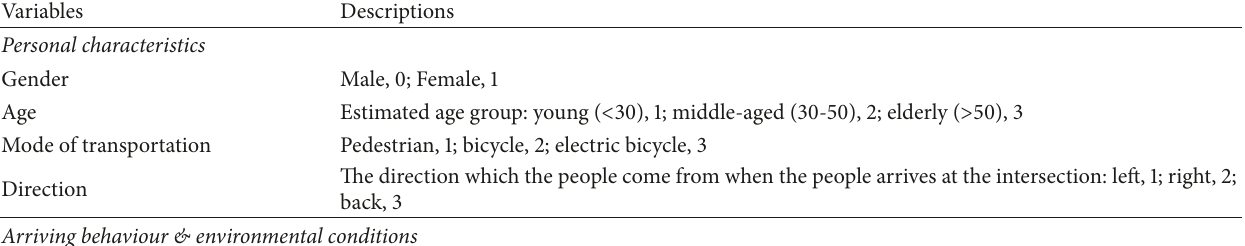
Table 2: Definitions of variables